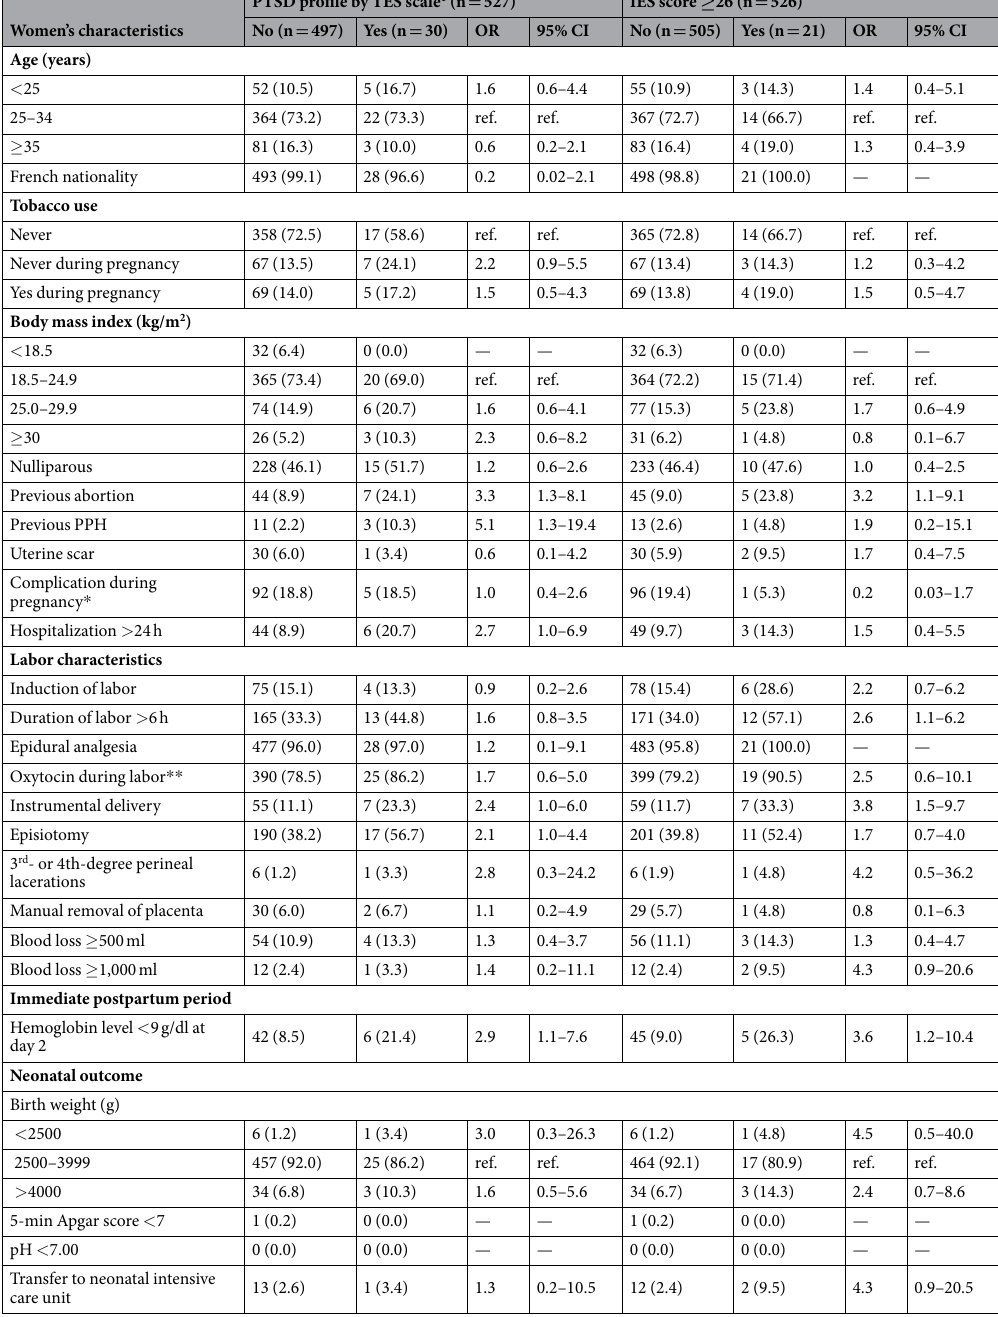
Table 3. Univariate analysis of factors associated with PTSD at one year after vaginal delivery. Data are no. (%) unless otherwise specified. PTSD, post-traumatic stress disorder; IES, Impact of Event Scale; TES, Traumatic Event Scale. 1 Criteria B, C and D on TES. * Complication during pregnancy including thrombocytopenia, gestational diabetes, bleeding, hypertensive disorders, or preterm labor. ** First and second stage.PPH, postpartum